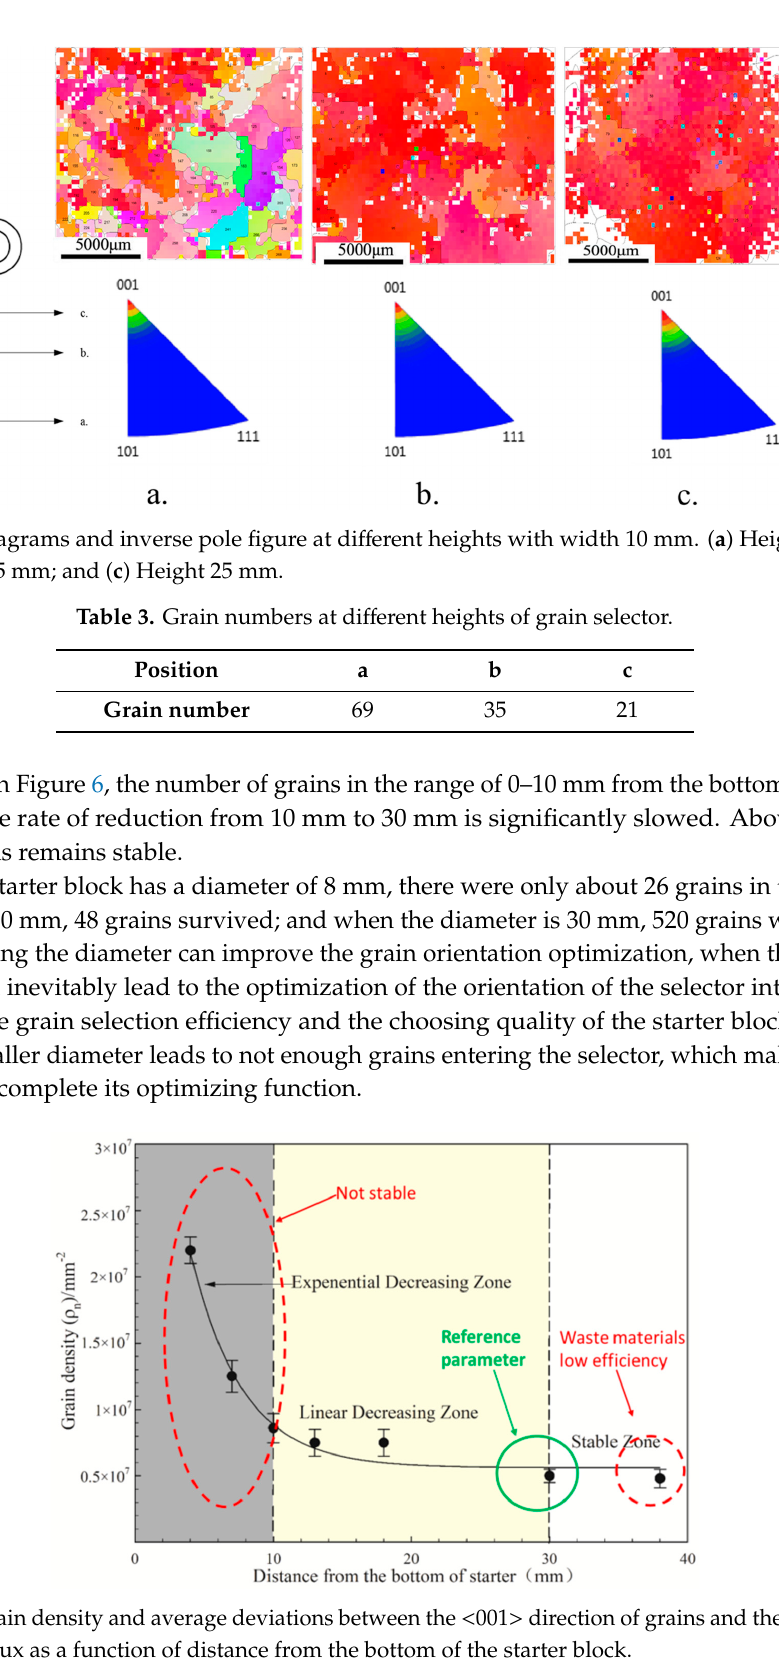
Figure 6. Grain density and average deviations between the <001> direction of grains and the direction of the heat flux as a function of distance from the bottom of the starter block.